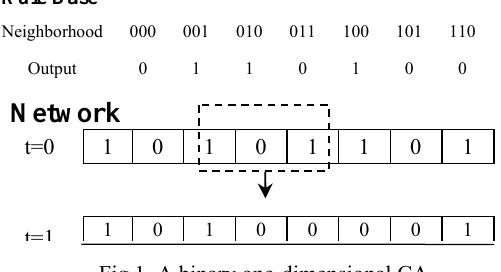
Fig 1. A binary one-dimensional